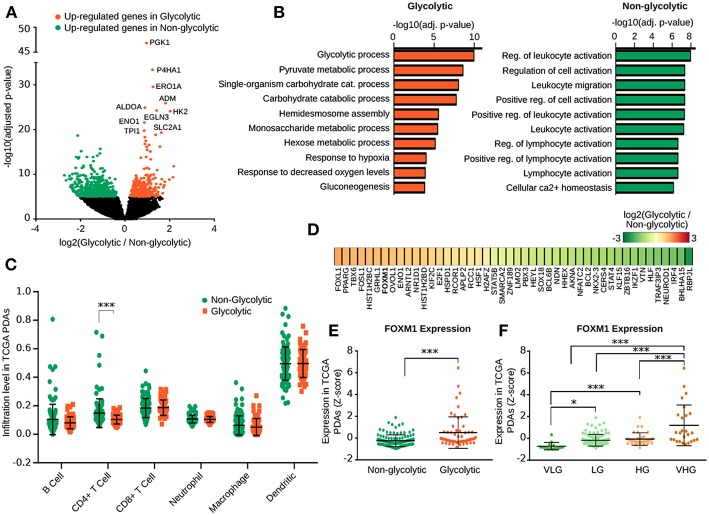
Transcriptional and immunological differences among PDA metabolic subtypes. (A) Volcano plot shows the expression fold change and the adjusted p-value of genes Differentially Expressed (DE) between the Gly and Non-Gly PDA subtypes. (B) Bar plot reporting the adjusted p-value of Gene Ontology biological processes enriched in genes up-regulated in the Gly (top) and Non-Gly (bottom) PDA subtype. (C) Dot plot reporting the levels of infiltrating immune cells computed with TIMER in the Gly and Non-Gly tumor subtypes. (D) Heat map reporting the log2FC of expression of transcription factors DE between the Gly and Non-Gly PDA subtypes. FOXM1 (highlighted in bold) was also predicted as upstream regulators by the Enrichr analysis. (E) Dot plot reporting the level of FOXM1 expression in the Gly and Non-Gly tumor subtypes. p-value by Wilcox Rank-Sum test. (F) Dot plot reporting the level of FOXM1 expression in the four glycolytic PDA subtypes. P-value was computed using Wilcoxon Rank-Sum test. ***p < 0.001.